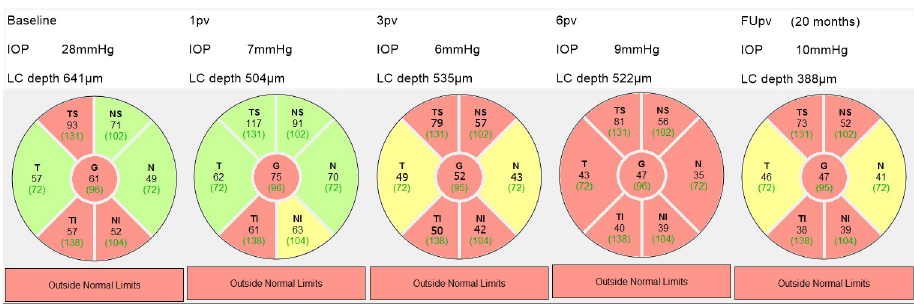
Fig 5. The time course of RNFL thinning with the corresponding IOP and LCD measurements for the right eye of a 62-year-old male patient. FUpv at 20 months. G = global, TS = temporal superior, T = temporal, TI = temporal inferior, NS = nasal superior, N = nasal, NI = nasal